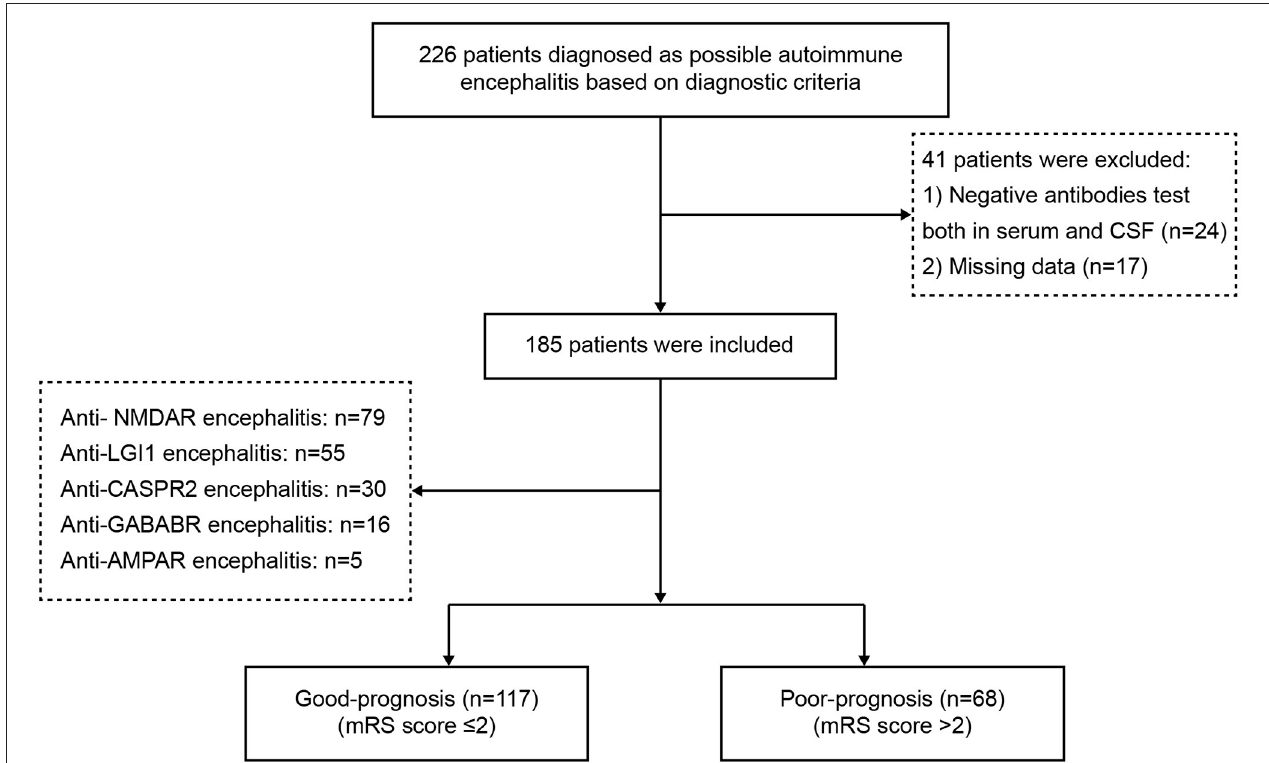
FIGURE 1 | The flowchart of patient selection. mRS, Modified Rankin Scale